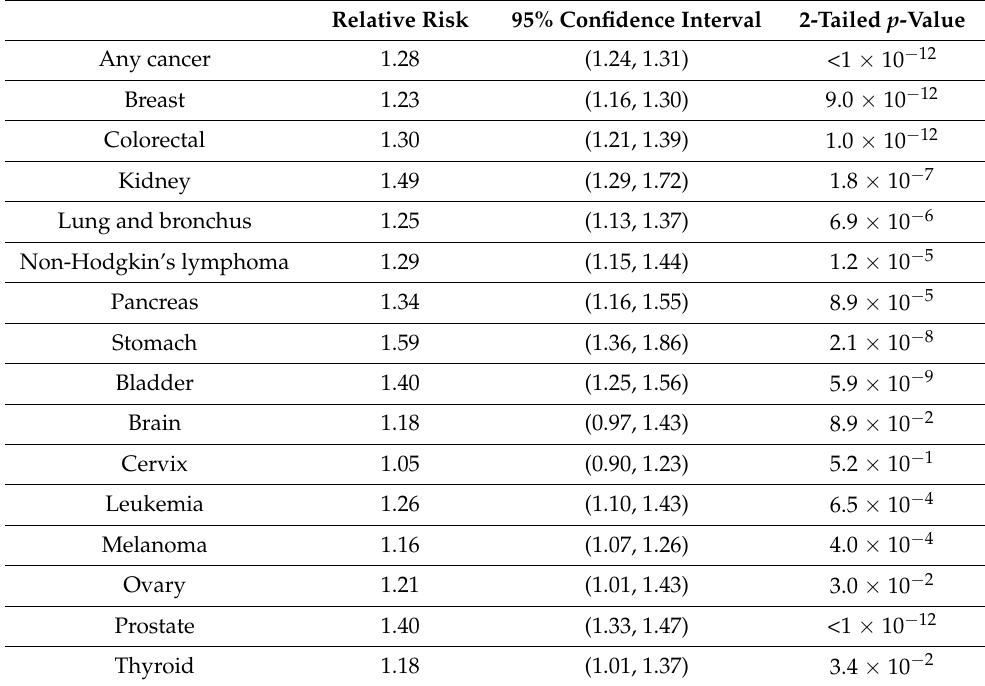
Table 2. Estimated RRs for 15 common cancers for the 85,787 individuals identified to be at high risk of AD based on family history.